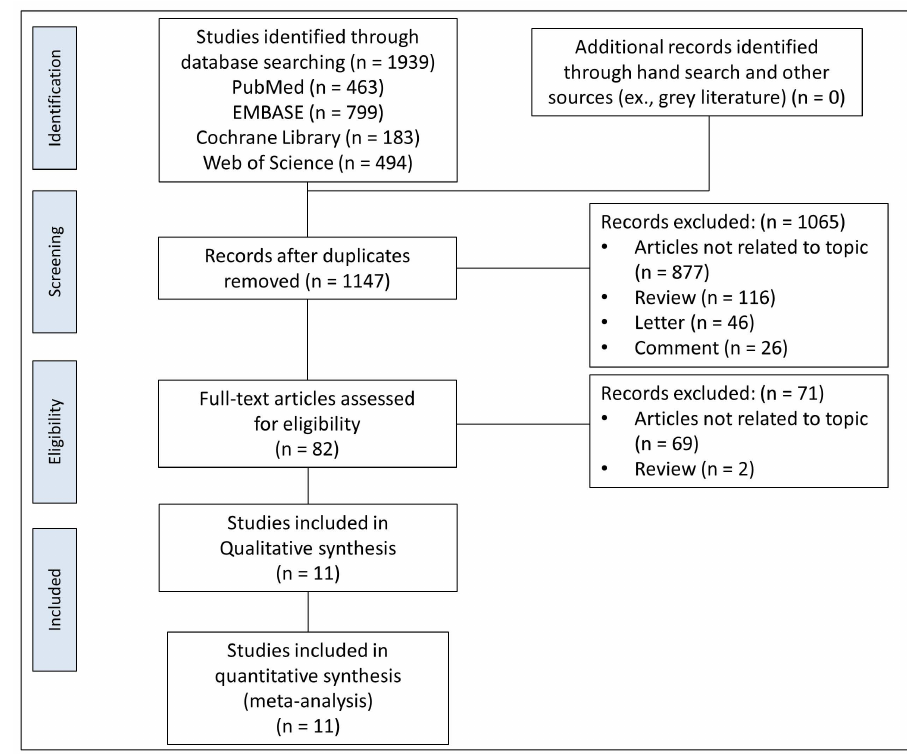
Figure 1. PRISMA flow diagram for selection of relevant